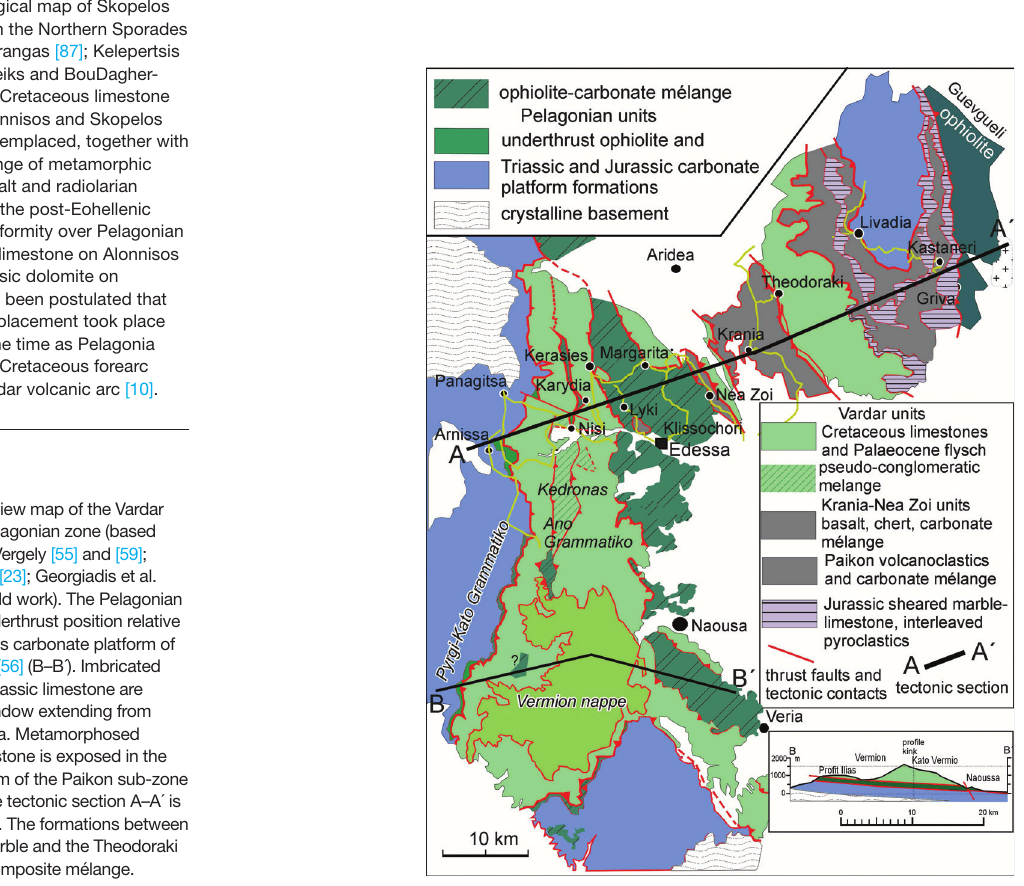
Closure of the Vardar Ocean from the early Middle Jurassic to the Paleocene time UCL OPEN ENVIRONMENT https://dx.doi.org/10.14324/111.444/ucloe.000024